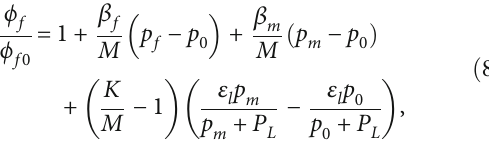
Figure 9: Deformation curves for C advancing